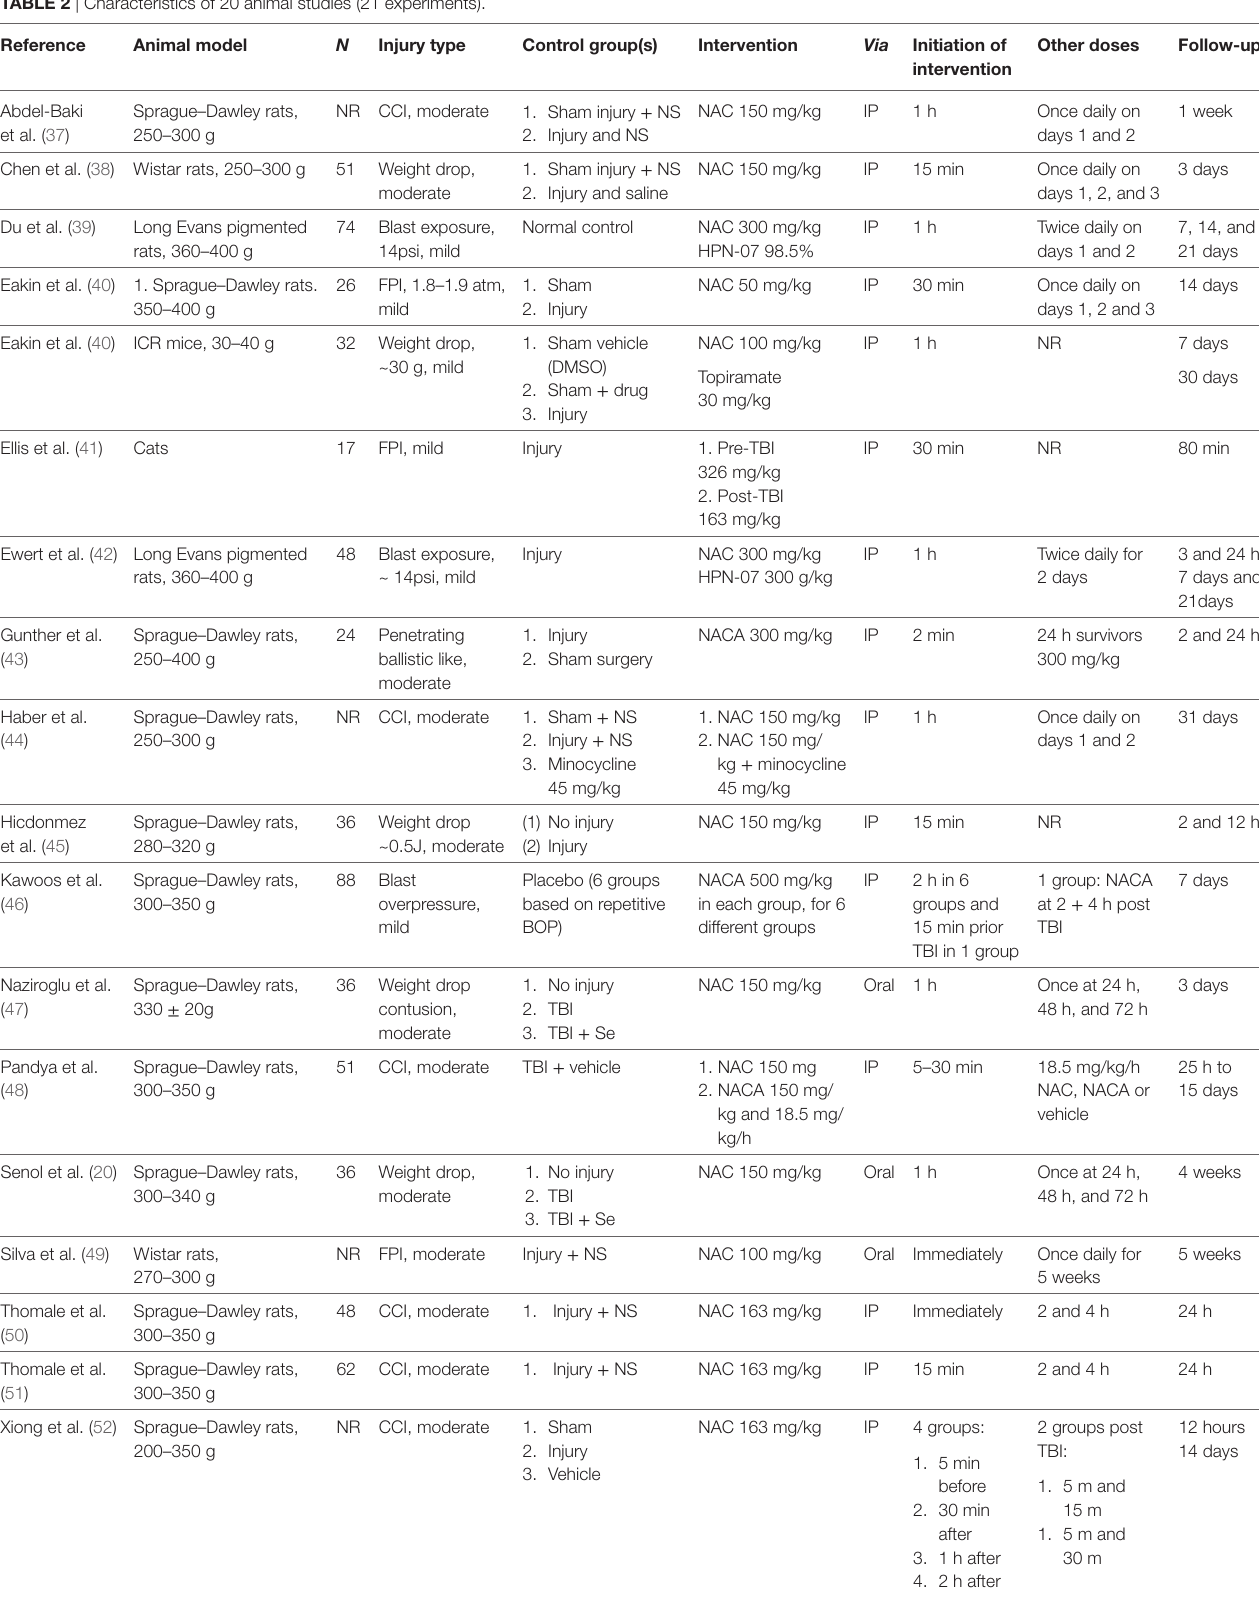
taBle 2 | Characteristics of 20 animal studies (21